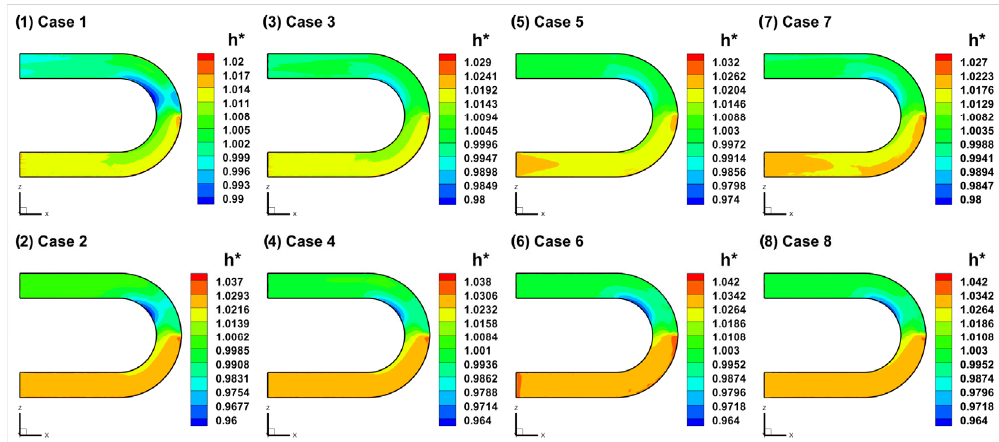
Figure 11. Contours of dimensionless water level in the main channel of all the cases.